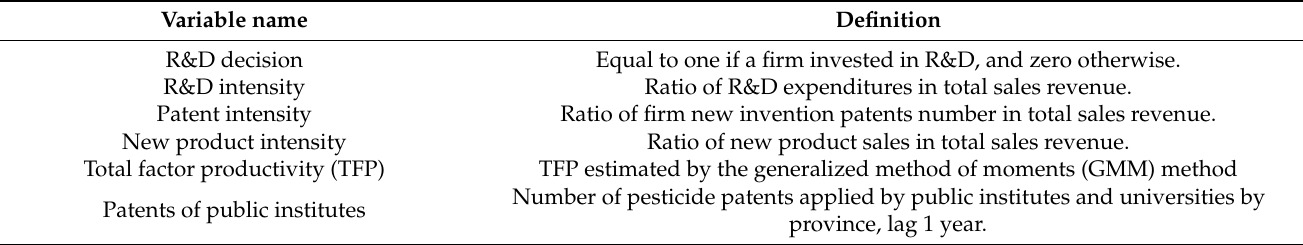
Table 1. Definition of all